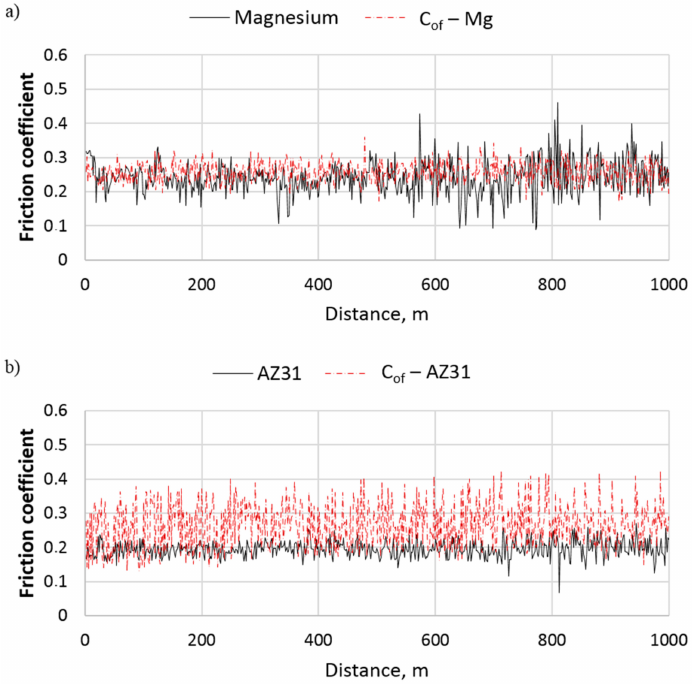
Figure 12. Changes of friction coe ffi cient determined for composites and reference matrix alloys over a distance of 1000 m, ( a ) magnesium and C of –Mg, ( b ) AZ31 alloy and C of